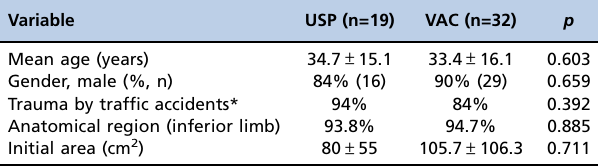
Table 1 - Demographics and Clinical Characteristics.